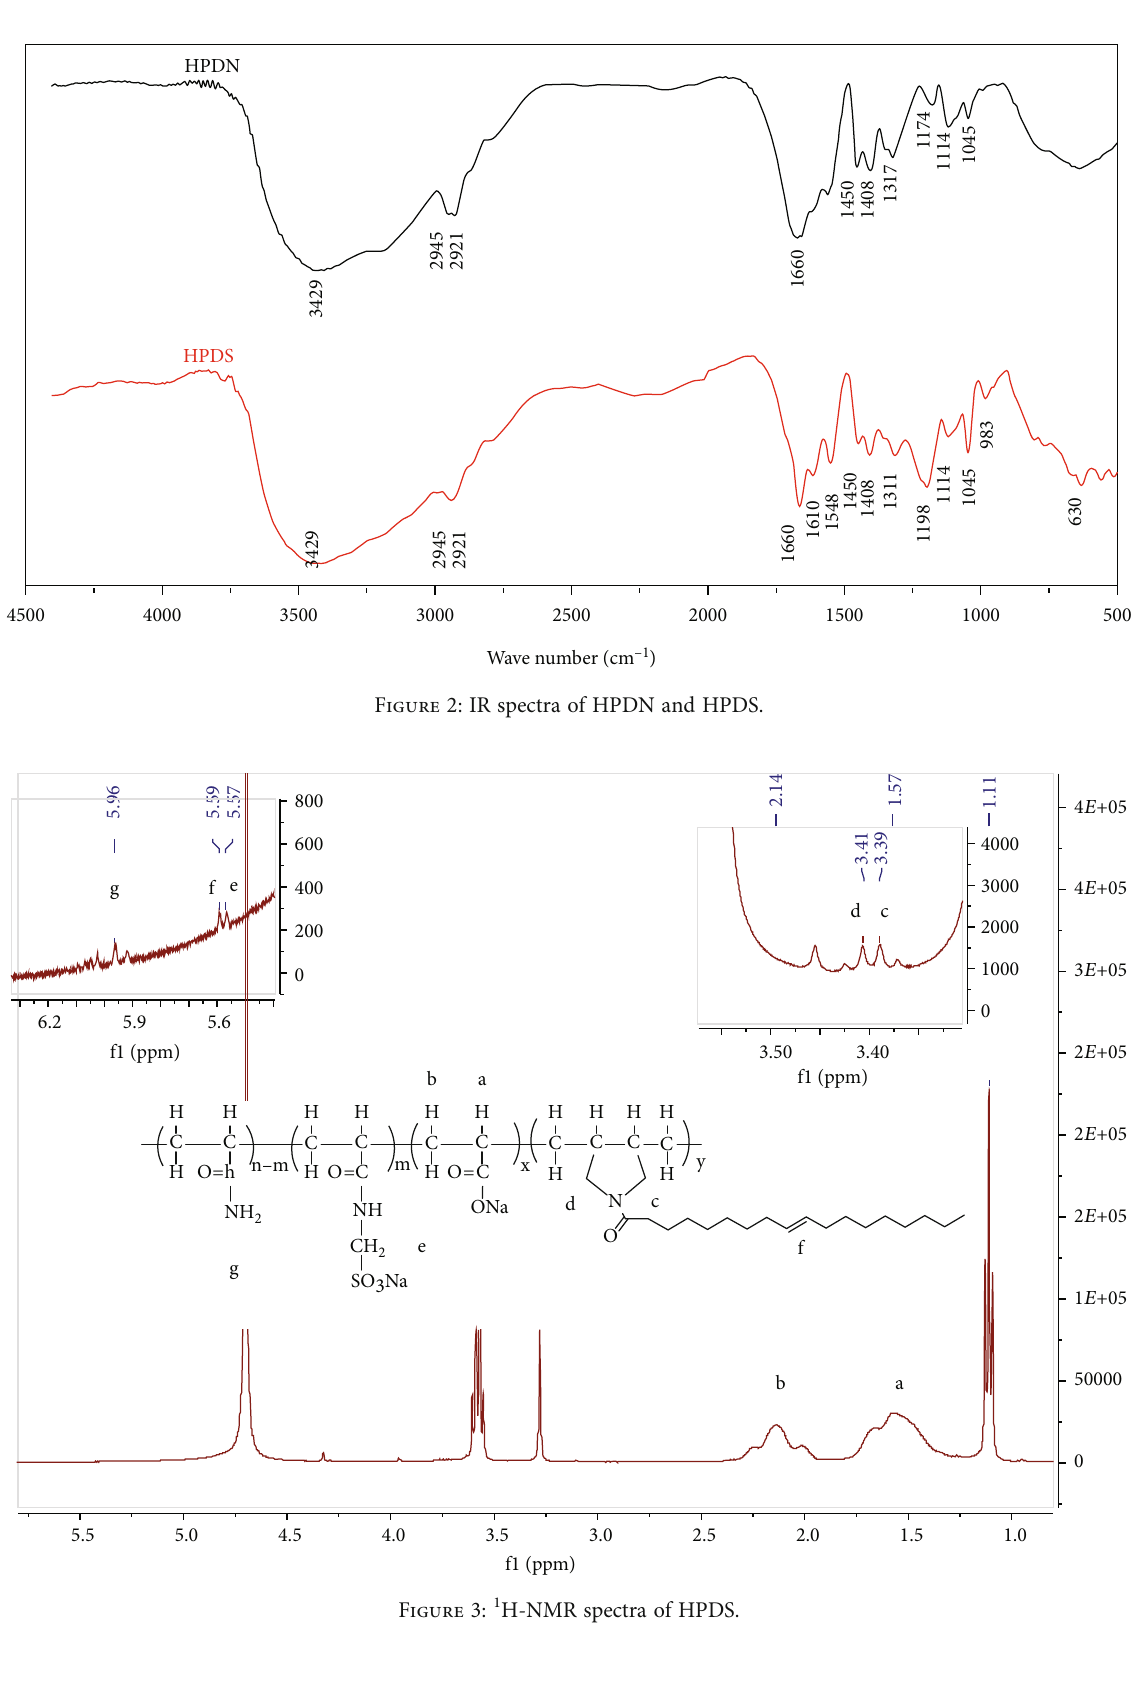
Figure 3: 1 H-NMR spectra of